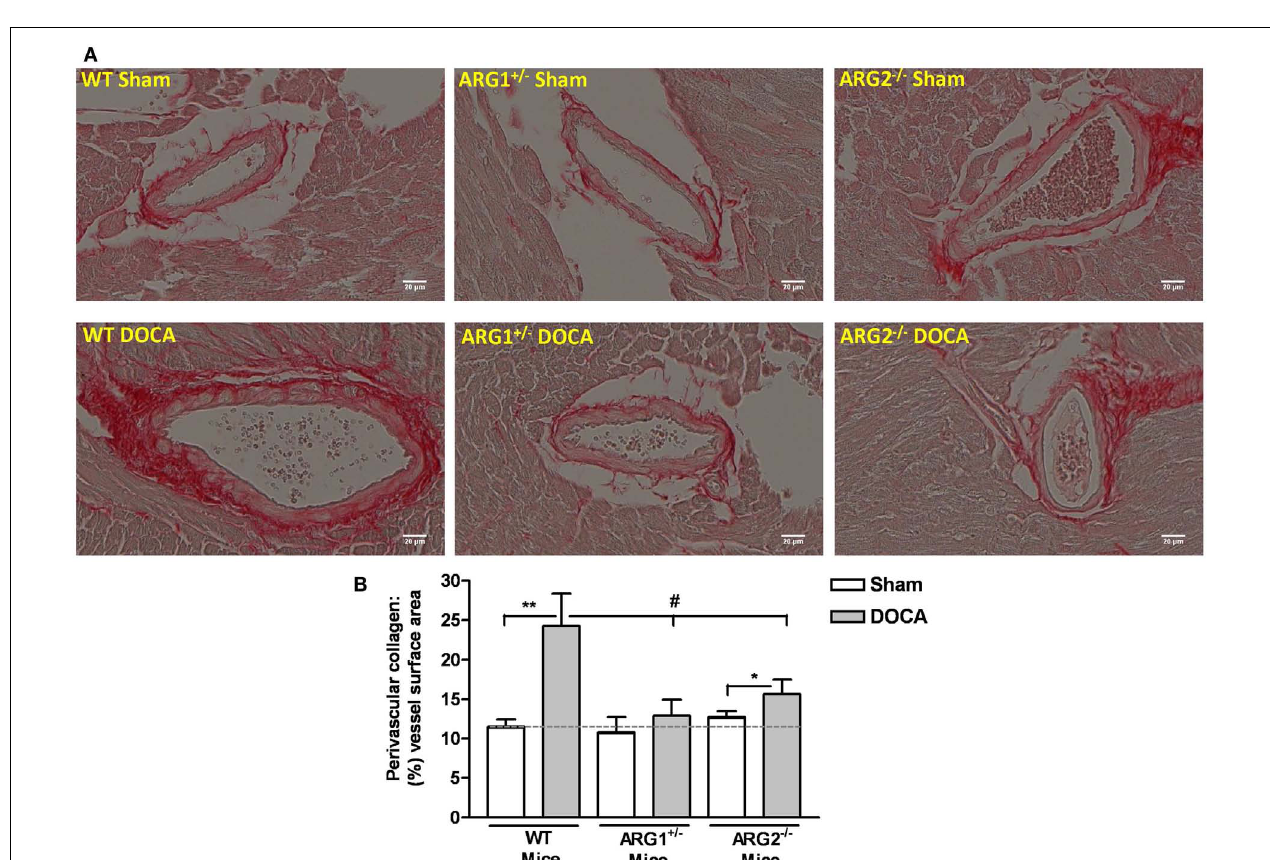
photograph of left ventricular paraffin-embedded tissue sections. Quantitative ratio of the perivascular collagen area to the vessel wall surface area is provided in (B) . Data are means ± SEM of three to four experiments. ** P < 0.01, * P < 0.05, compared with its Sham group. # P < 0.05, compared withWT-DOCA